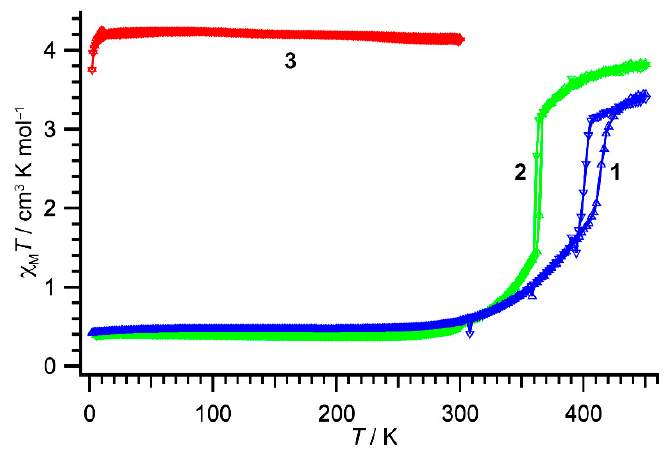
Figure 3. The χ M T vs. T products for 1 (blue triangles), 2 (green triangles), and 3 (red triangles). Triangles up and down indicate heating and cooling processes, respectively. Lines are used to guiding the eye.